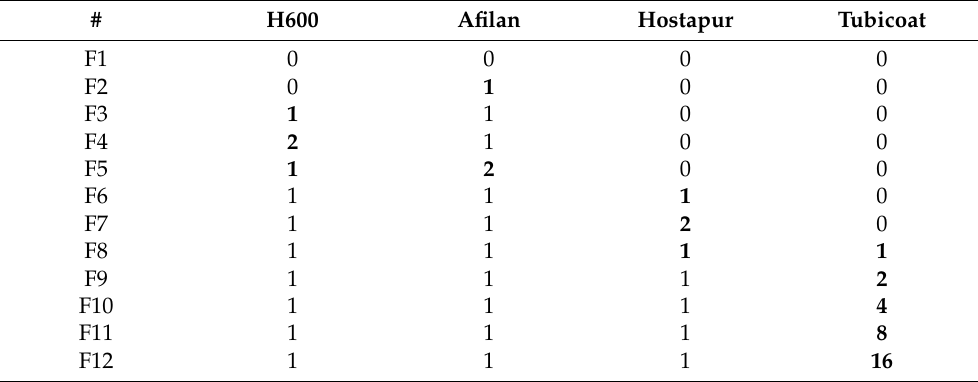
Table 1. Acrylic foam formulations. All values are the weight percentage of the total formulation. Values in bold indicate changes relative to the previous